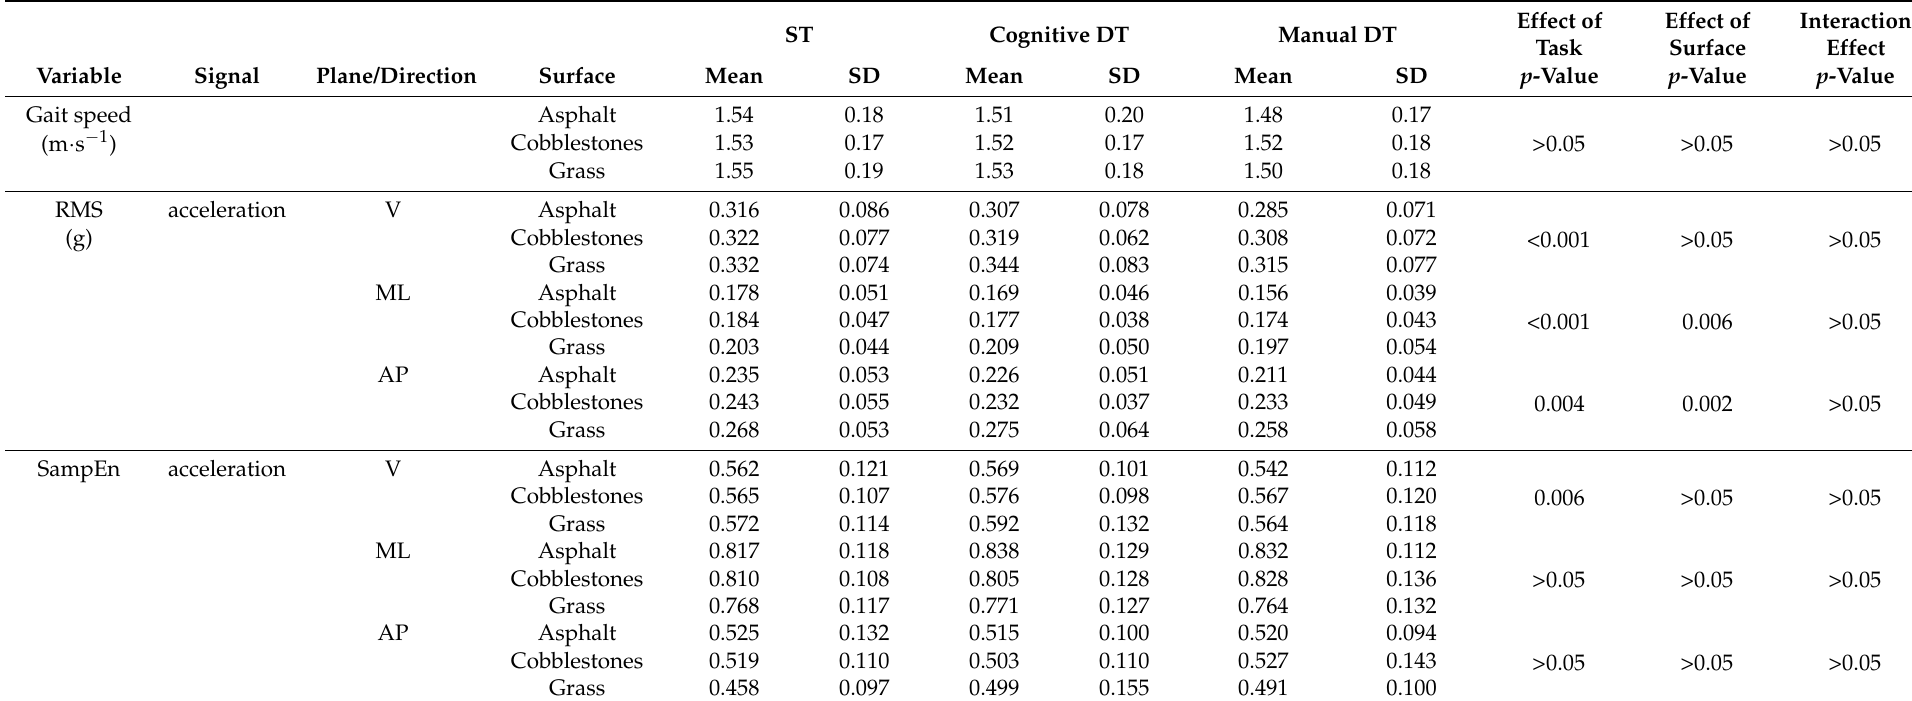
Table 1. Gait velocity, root mean square (RMS) and sample entropy (SampEn)